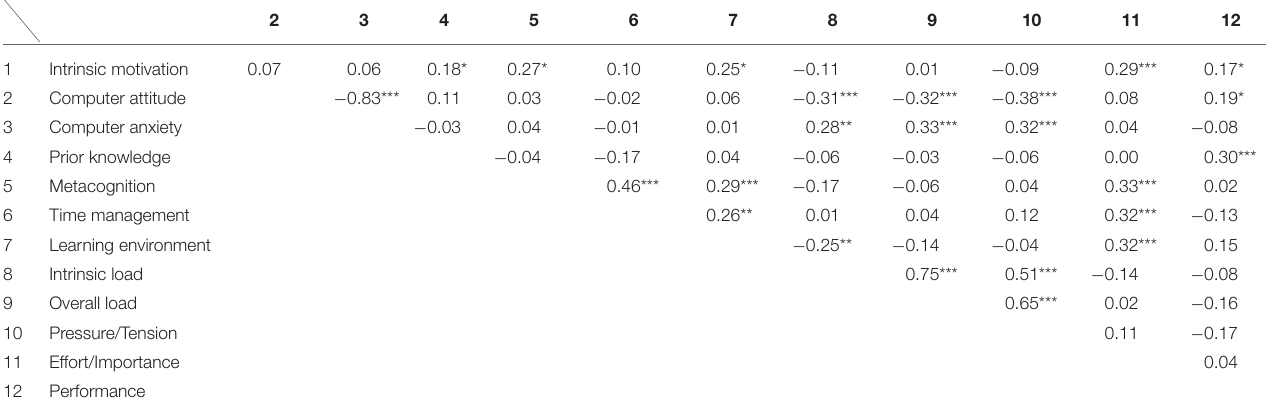
TABLE 2 | Correlations between the variables used for prediction and the predicted